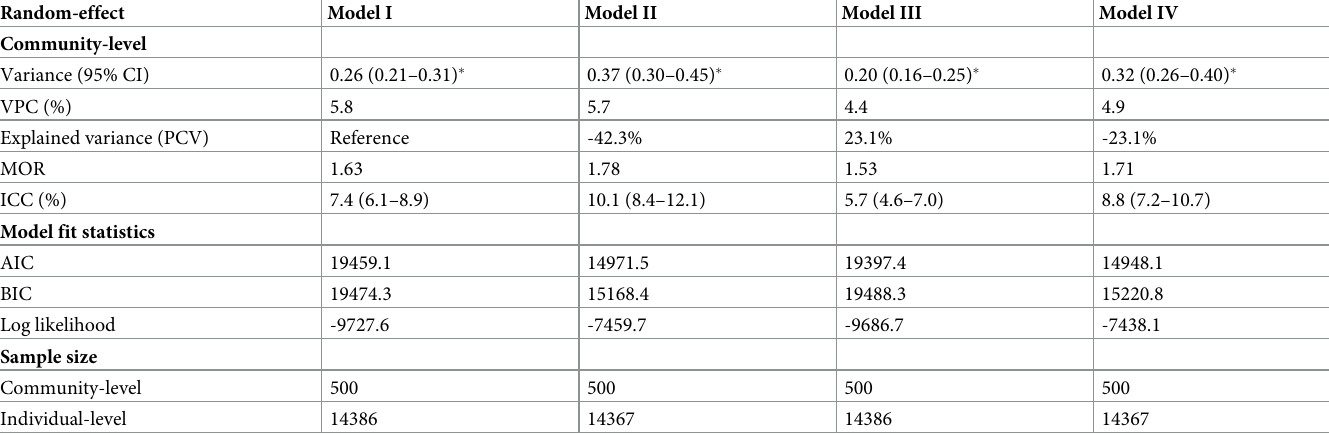
Table 2. Random effect estimates of contextual factors associated with prenuptial HIV/AIDS testing among reproductive-aged women in